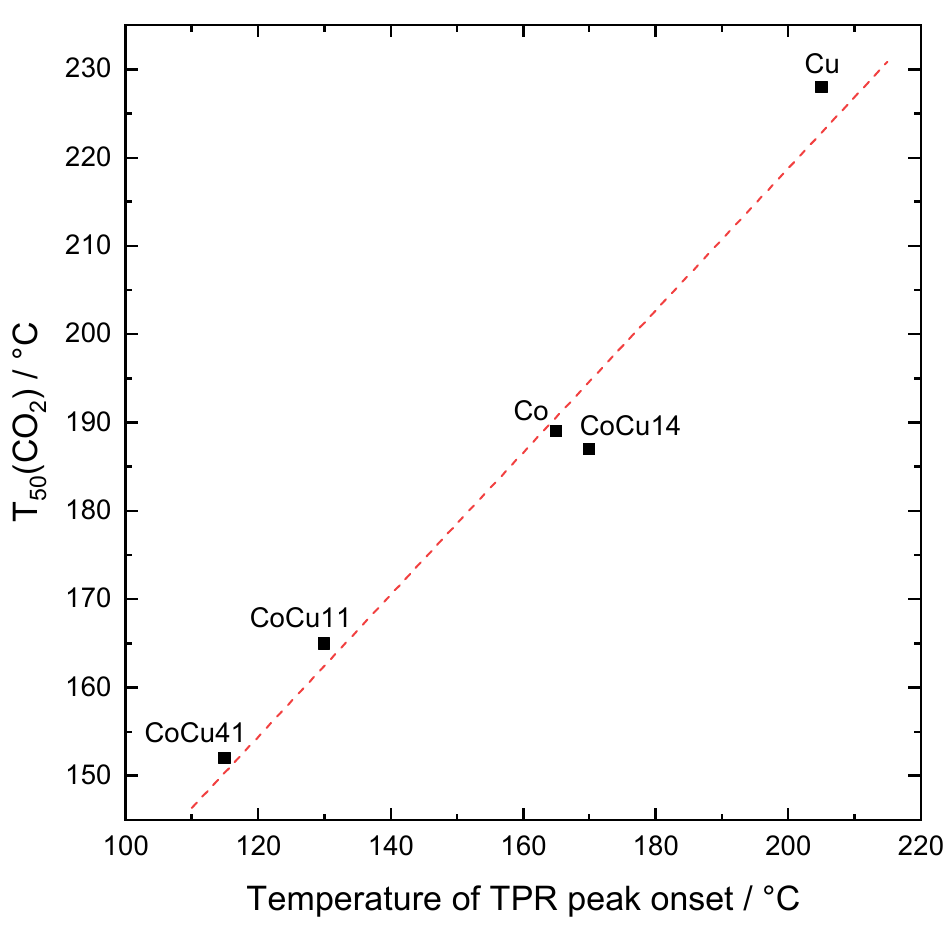
Figure 9. Correlation between the temperature of the reduction onset in the H 2 -TPR experiments and the T 50 (CO 2 ) temperature, at which 50% conversion of ethanol to CO 2 was